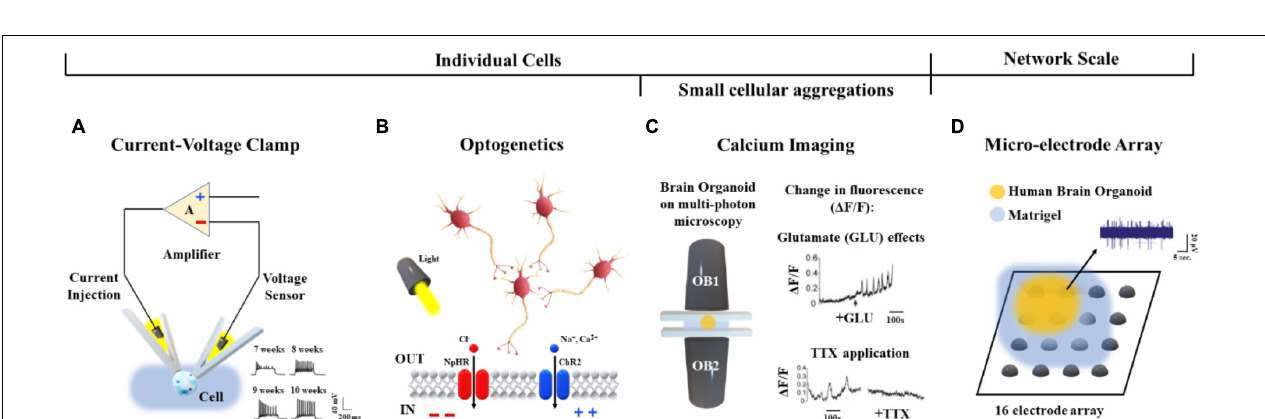
FIGURE 6 | Functional characterization approaches applied to human brain organoids. (A) Voltage/current clamp technique and representative recordings (bottom, right) from hiPSC-derived organoids after 7, 8, 9, and 10 weeks in vitro (Hartfield et al., 2014). (B) Cellular polarization changes can be achieved in a cell-type-specific manner via optogenetics by means of light activation of specific DNA-encoded light-sensitive ion channels (e.g., the channel rhodopsin ChR2 colored in blue) or inhibitory pumps (e.g., the halorhodopsin NpHR colored in red) (Rajasethupathy et al., 2016). (C) Calcium imaging based on multi-photon microscopy (left) and detected changes in fluorescence ( (cid:49) F/F) induced by Glutamate (top, right) and TTX (bottom, right) (Lancaster et al., 2013). (D) Representative midbrain organoid coupled to a 16-electrode array in a 48-well tissue culture plate and spontaneous activity from one active recording